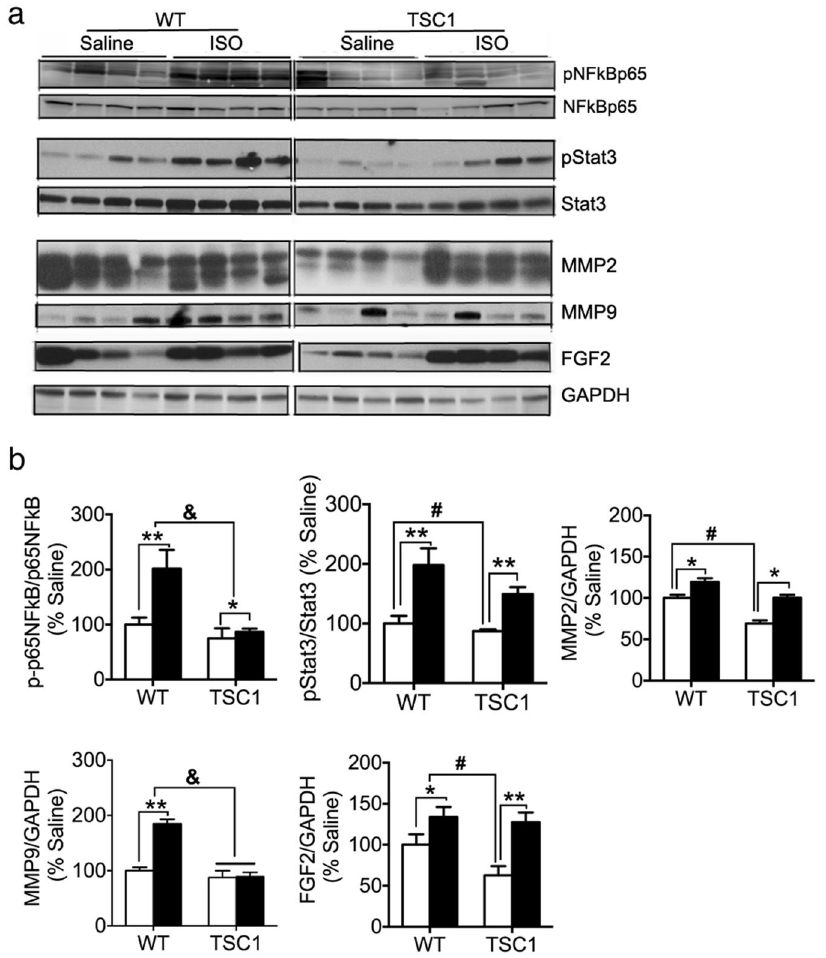
Figure 8. Fibrosis and inflammatory response in the heart of aged mice and the heart of mice after isoproterenol challenge. ( a ) Western blot analysis of NF κ B, Stat3, FGF2 and MMP2/9 in heart protein extracts from old female mice (22–24 months of age, n = 6). ( b ) Quantification of protein band intensity (n = 6). WT – wild type mice; TSC1 - Tsc1 tg mice. White bar – saline-injected mice; black bar – isoproterenol-injected mice. Asterisks ( * p < 0.05 and ** p < 0.01) indicate statistical significance between isoproterenol injected and saline injected mice of the same genotype as indicated in the